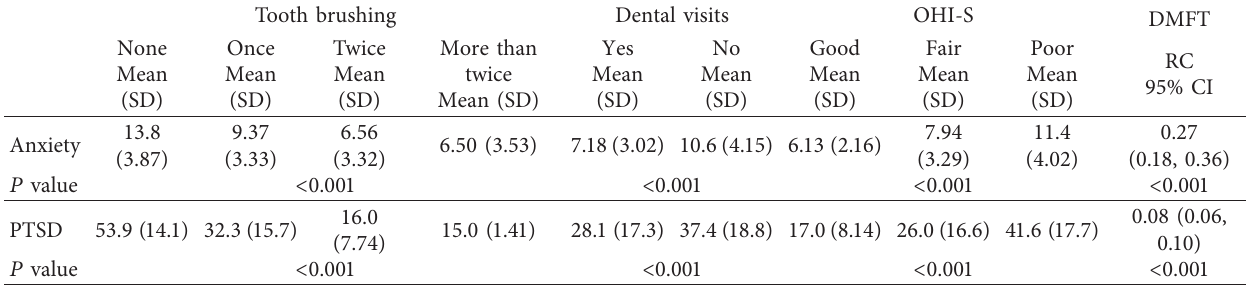
Table 3: Association of psychological measures with oral health behaviours and dental status. Tooth